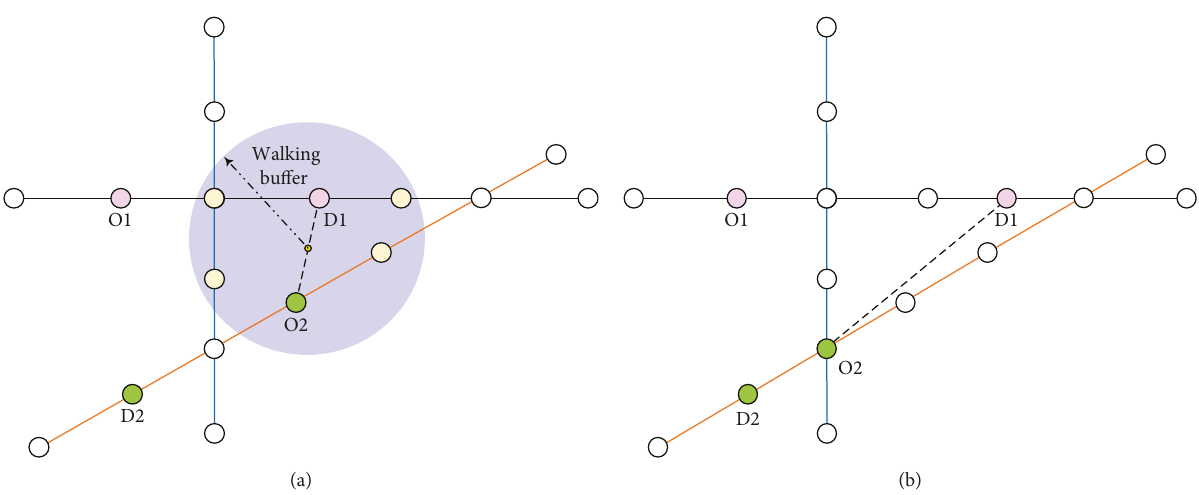
Figure 4: The assumption for actual destination and potential alighting station choices. Pink circles are the boarding and alighting stations of the fi rst trip. Green circles are the boarding and alighting stations of the next trip. Yellow circles are candidate alighting